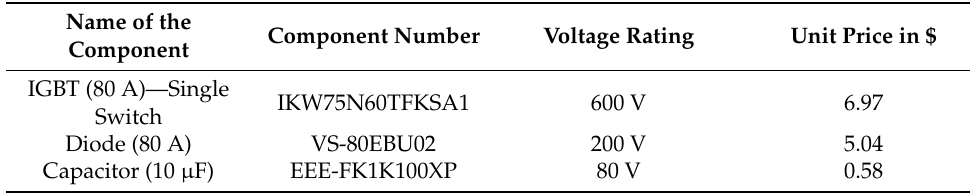
Table 7. Unit price of the circuit components.